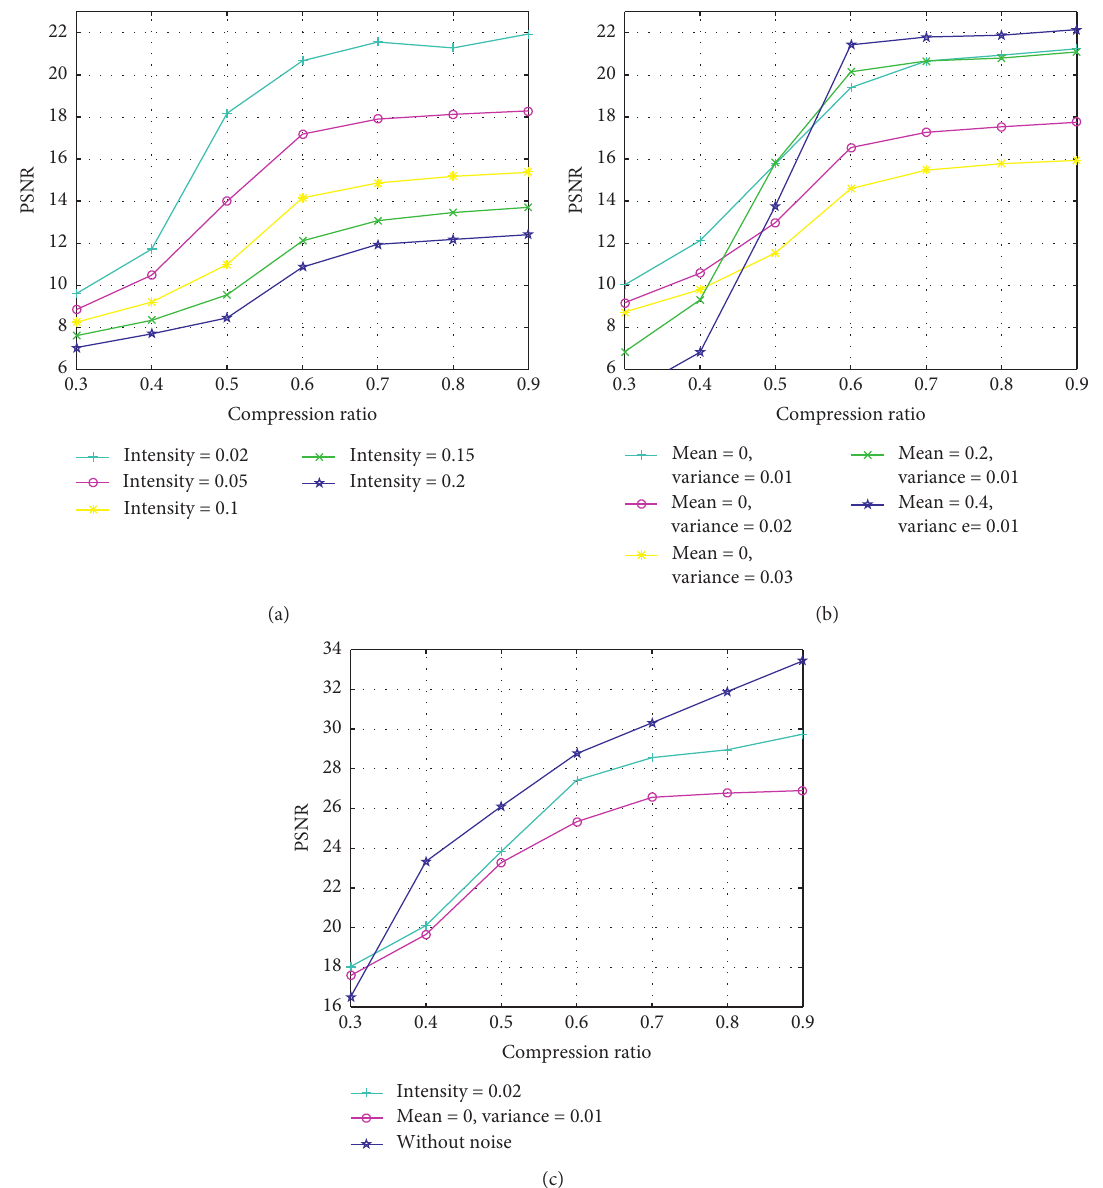
Figure 11: PSNR of reconstructed image: (a) PSNR of impulse noise, (b) PSNR of Gaussian noise, and (c) PSNR of filtered